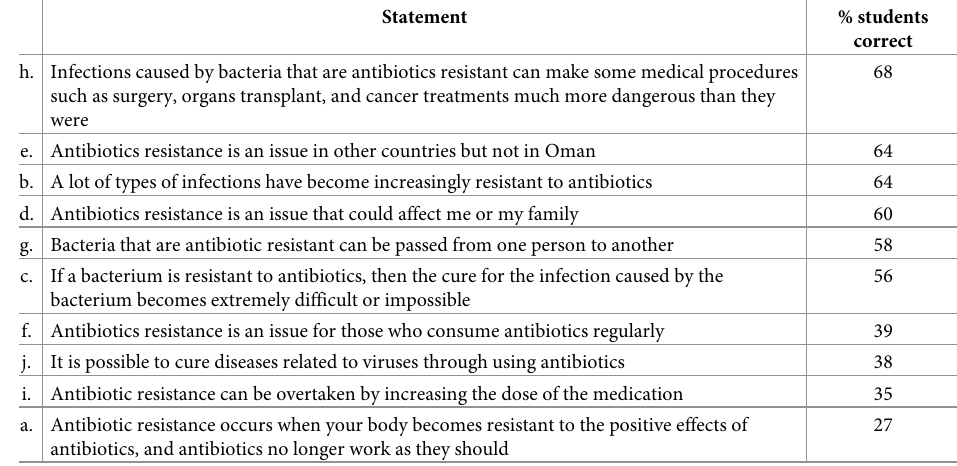
Table 8. Percentage of participant with correct responses to statements about antibiotic resistance (Survey Q13).